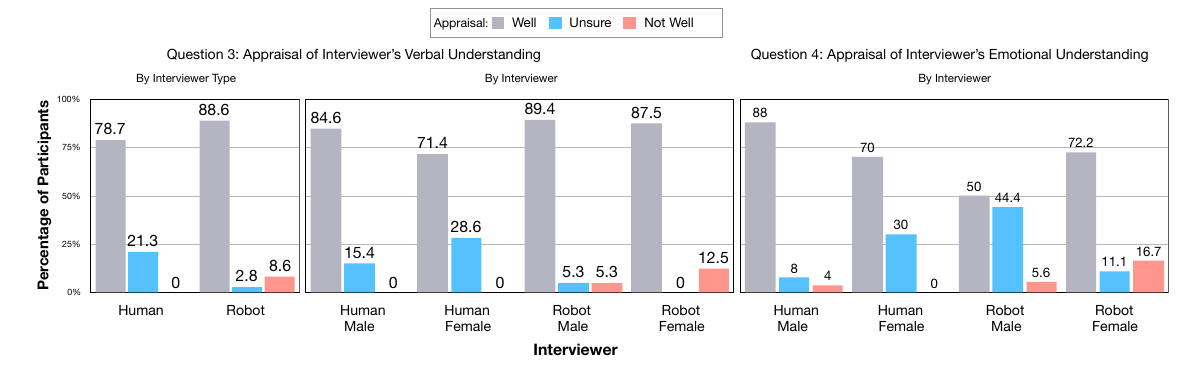
Figure 5: Participant responses to questions about the interviewer’s ability to understand what they said and how they felt.